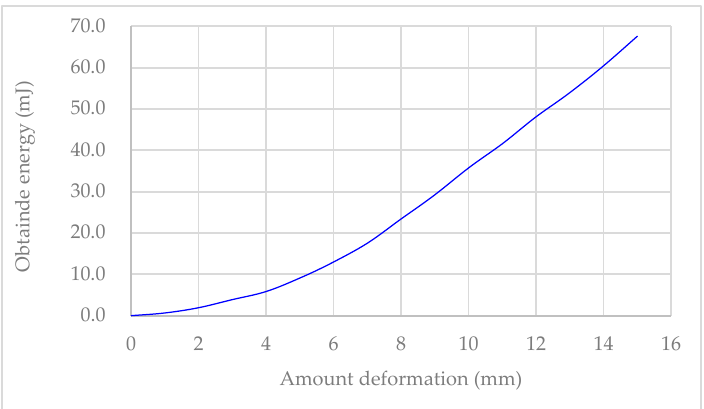
Figure 17. The relationship between the amount deformation (mm) when the acrylic rod installed in the center of the DE cartridge is pushed in the vertical direction, and the obtained energy (mJ).